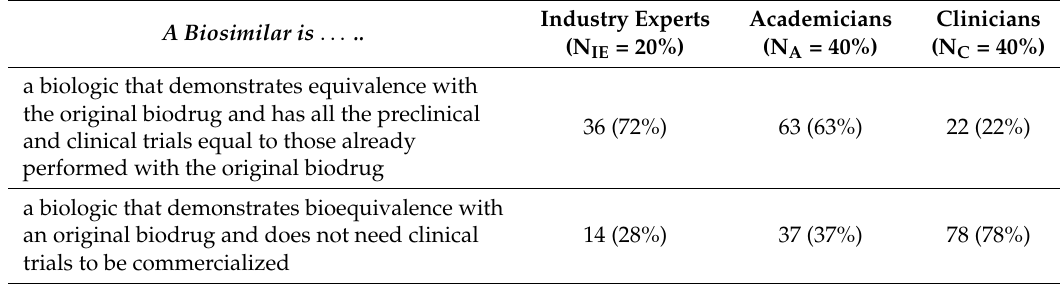
Table 2. Understanding of biosimilars among Industry Experts, Academicians and